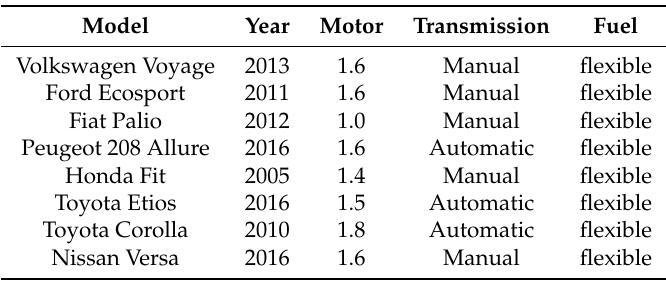
Table 4. Selected